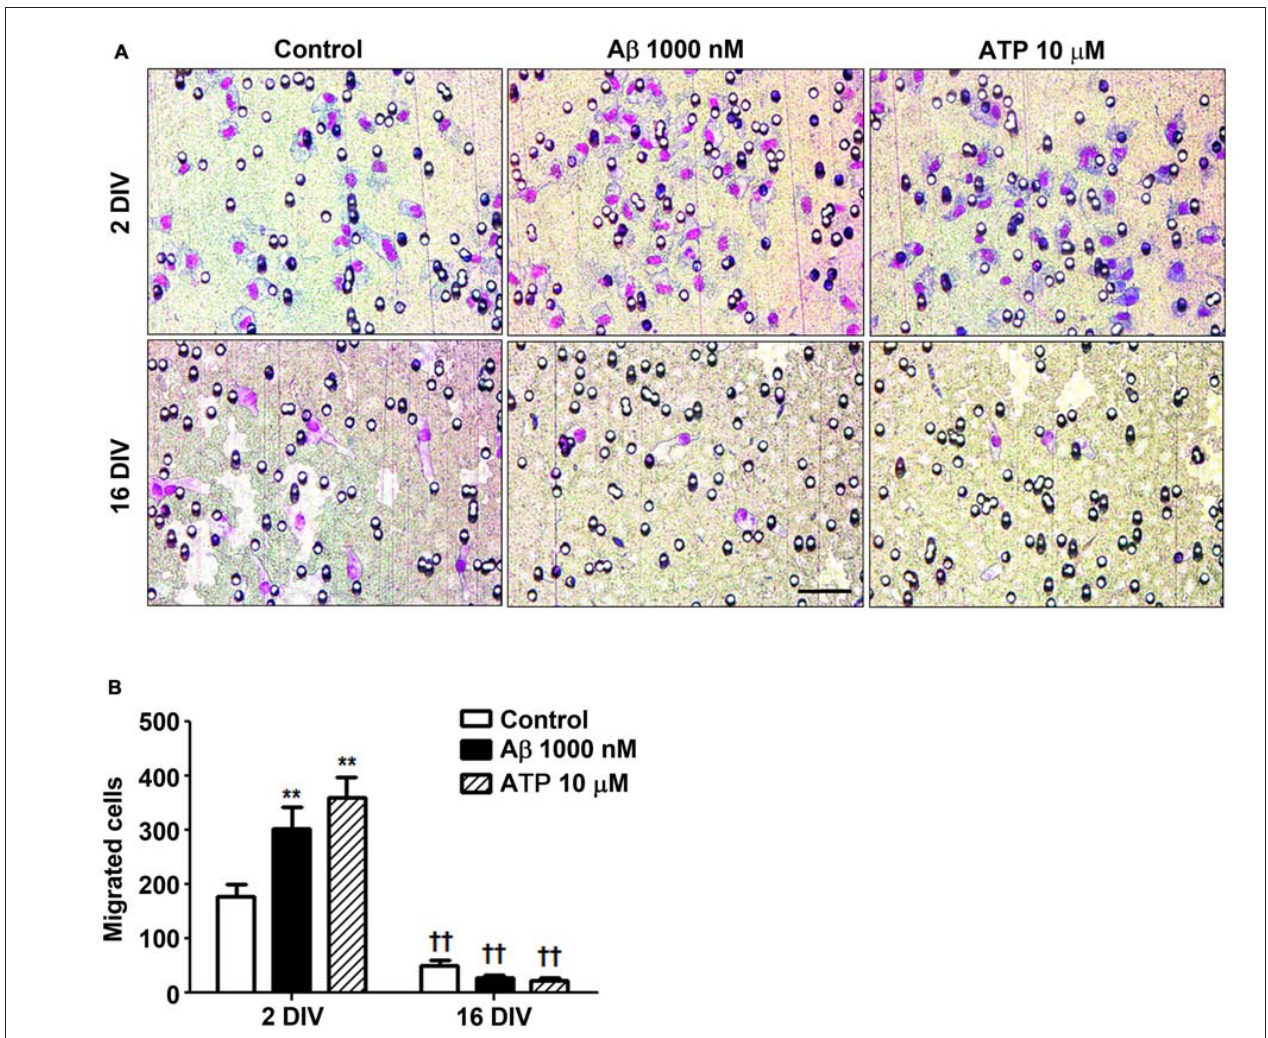
FIGURE 5 | Reactive cultured microglia show increased ability to migrate towards amyloid- β (A β ) peptide and ATP, while aged microglia are immotile and unresponsive to such chemoattractants. Microglia were kept in culture for 2 and 16 days in vitro (DIV) and cellular chemotactic migration to 1000 nM A β and 10 µ M ATP (positive chemotactic control) was evaluated after 6 h incubation using the Boyden chamber method. (A) Representative images of cells that have migrated to A β and ATP. Scale bar equals 50 µ m. (B) Number of migrated cells was counted and results are expressed in graph bars as mean ± SEM. Cultures, n = 4 per group. Two-way ANOVA ( Post hoc Bonferroni test): ∗∗ p < 0.01 vs. respective non-treated Control; †† p < 0.01 vs. 2 DIV cells; (B) DIV × A β interaction F ( 4.36 ) , p <